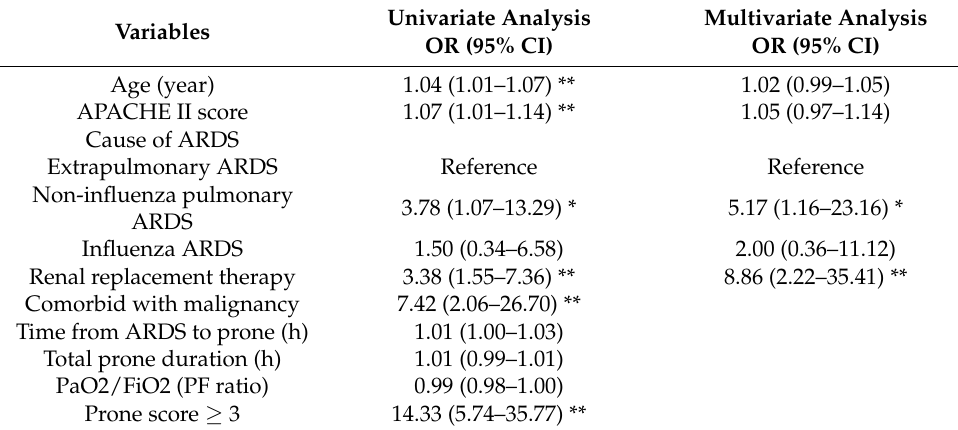
Table 3. Logistic regression analysis of clinical variables associated with ICU mortality in patients with ARDS receiving early and prolonged prone positioning.